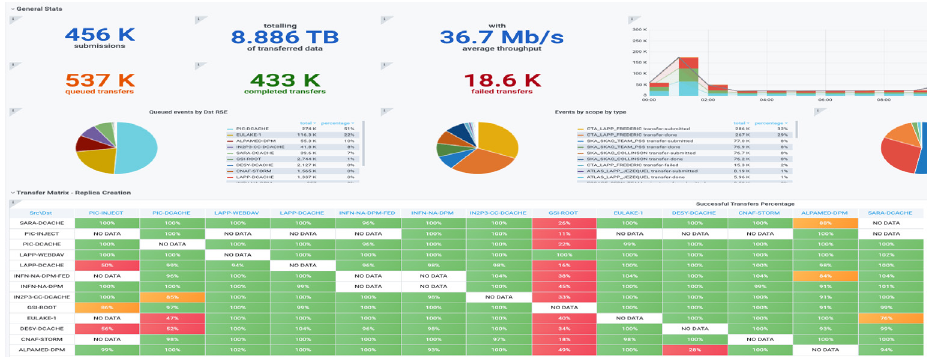
Figure 5: Rucio events dashboard (FDR